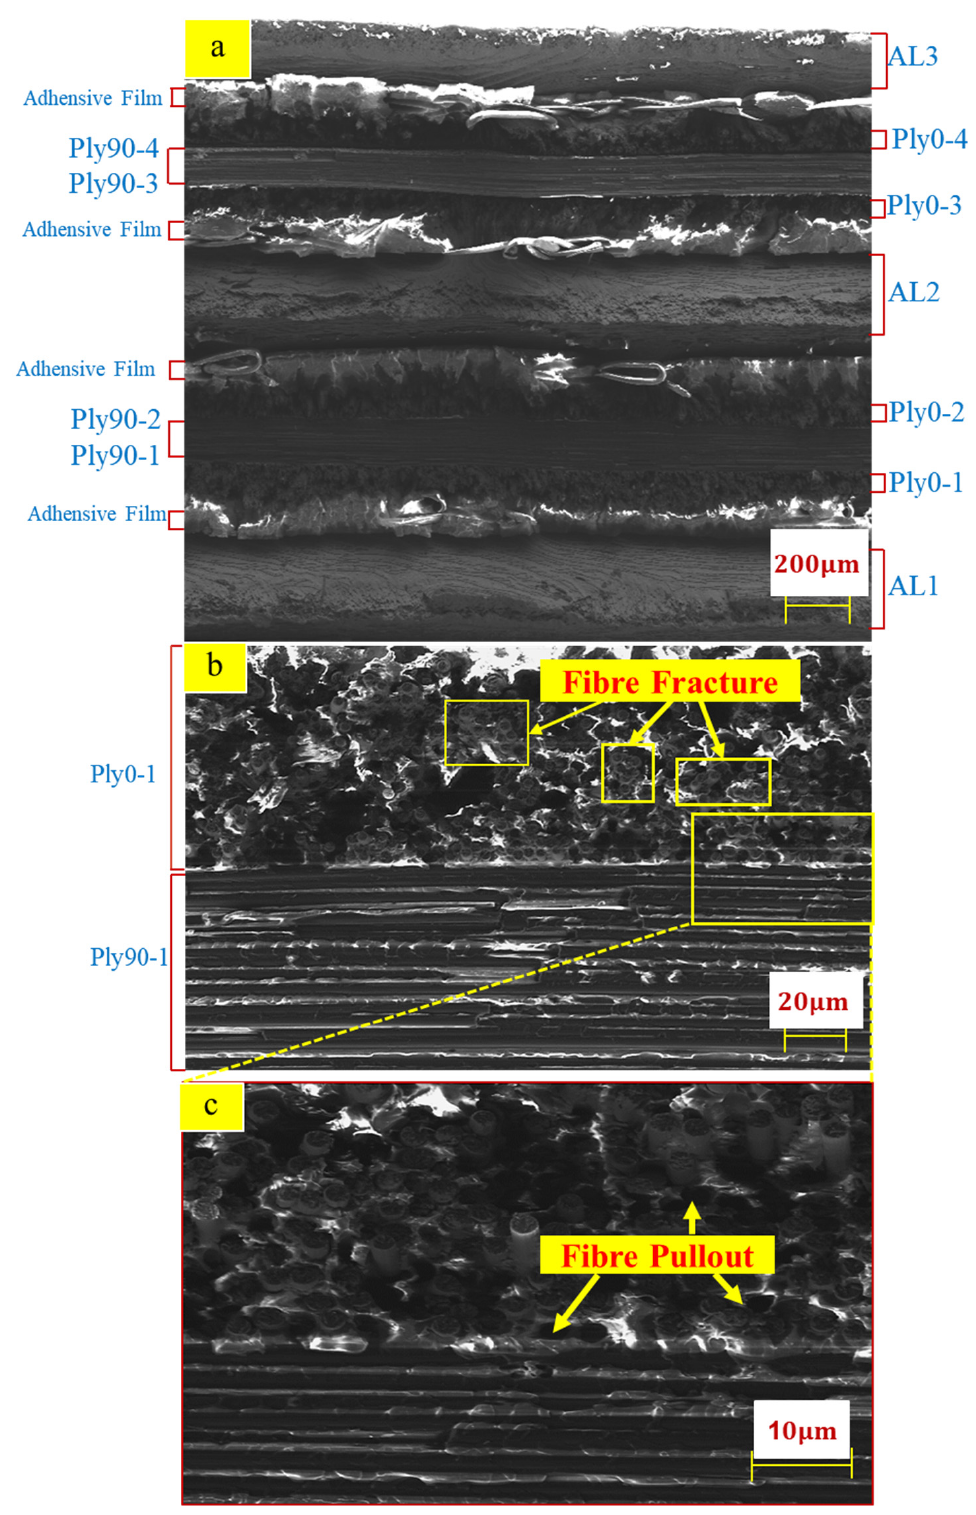
Figure 11. SEM morphologies of tensile specimen fracture ( a ) overall cross-section ( b ) SEM mor- phologies of the Ply0-1 and Ply90-1 layers ( c ) Partially enlarged view of Ply0-1 and Ply90-1.